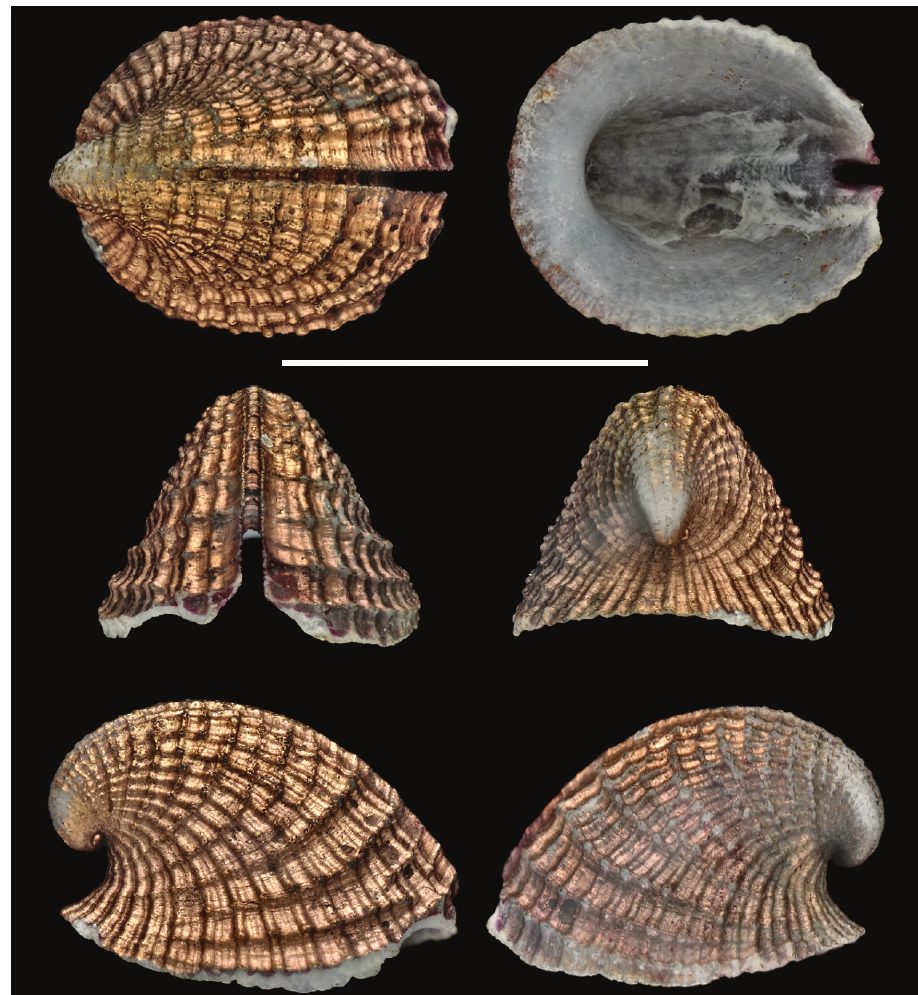
Figure 8. Emarginula phrygium Herbert & Kilburn, 1986. Holotype T3012/NMSA-MOL 0C6844. Scale bar: 5